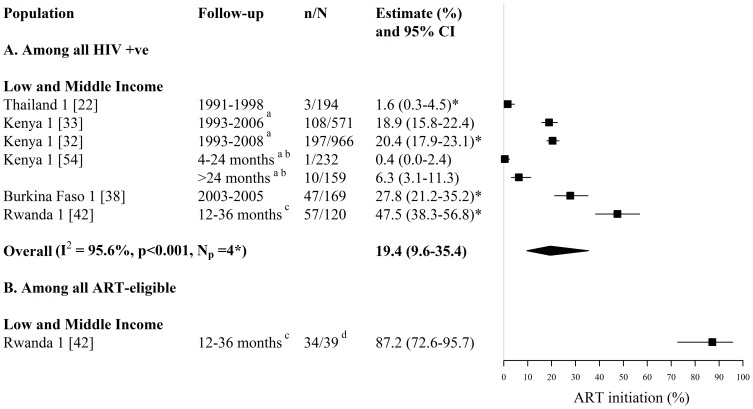
Forest plot of ART initiation among (A) all HIV-infected FSWs and (B) all ART-eligible FSWs.Study estimates are grouped by country income and ordered by follow-up period. The star symbol (*) highlights the individual study estimates (one per study population) included in the pooled overall estimate. I2 and p-values are the measures of heterogeneity used. a ART was provided to FSWs in the Kenyan cohort from 2004, b Follow-up refers to months since HIV-diagnosis, study recruitment occurred between 1993 and 2009, c Follow-up refers to months since HIV-diagnosis, study recruitment occurred between 2006 and 2008. d N refers to HIV-infected ART-eligible FSWs who had enrolled in HIV care following HIV diagnosis. ART  =  antiretroviral therapy, FSW  =  female sex workers, CI  =  confidence interval, n =  number of FSWs with each outcome, N =  sample size of FSWs available for each outcome, Np =  number of independent study populations.